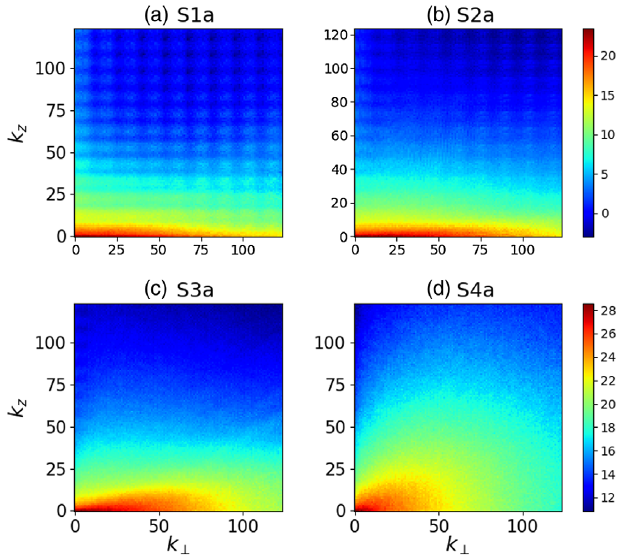
FIG. 6. The k z - k ⊥ wave-number spectrum for the velocity field of Alfv´en modes with increasing Mach number. The color indicates the logarithm of the spectrum power. S1a is the lowest Mach number of 0.24, going up to S4a, which has the highest Mach number of 0.99. The power spreads more in the parallel direction as the Alfv´en Mach number